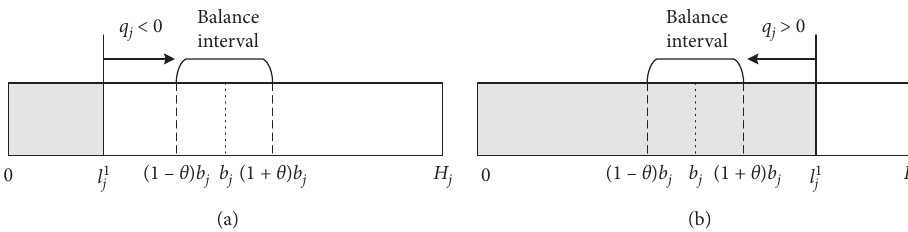
Figure 4: BSS station with balance interval. The grey area represents the current level of occupation, while the white area represents the current vacant slots. H j is the maximum capacity of station j . (a) Delivery rebalance demand. (b) Pickup rebalance